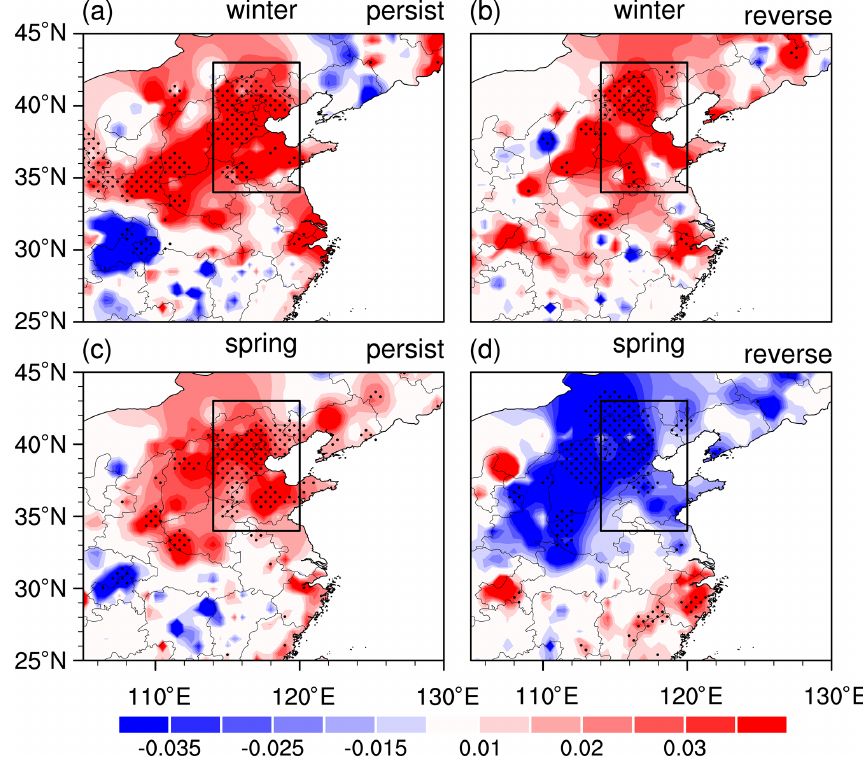
Figure 3. Composite anomalies of the DECC (unit km − 1 ) in (a, b) winter and (c, d) spring in the (a, c) persistent years and the (b, d) reverse years. Stippled regions indicate anomalies significant at the 5%